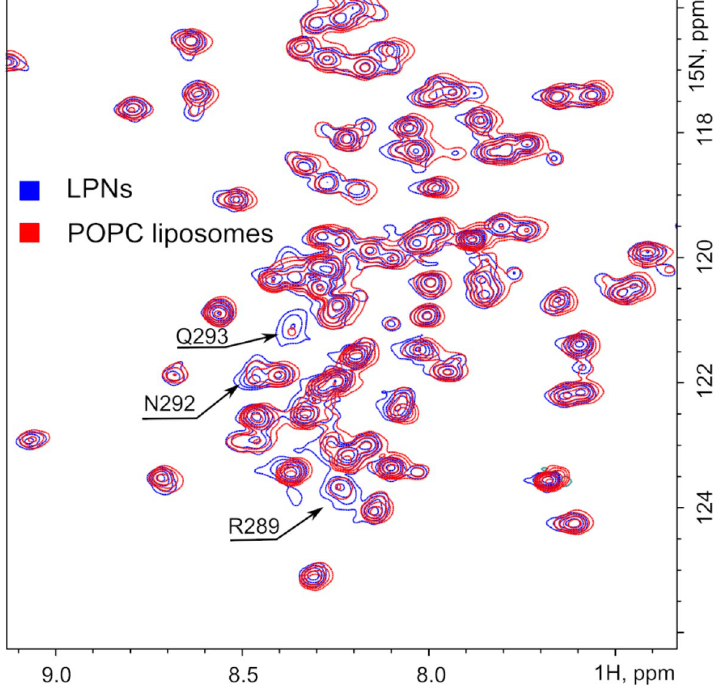
Figure 6. NMR analysis of rP75-ΔECD-3CX incorporated in nanodiscs and POPC liposomes. Fragment of 2D- 1 H, 15 N-TROSY-HSQC spectrum of dimeric rP75-ΔECD-3CX in MSP1D1 LPNs (shown in blue) and POPC liposomes (red). Both samples were prepared at lipid-to-protein ratio (LPR) 150. Assignments of amide group signals with the visible line broadening are indicated. The figure was prepared using the program Inkscape 0.92 (https ://inksc